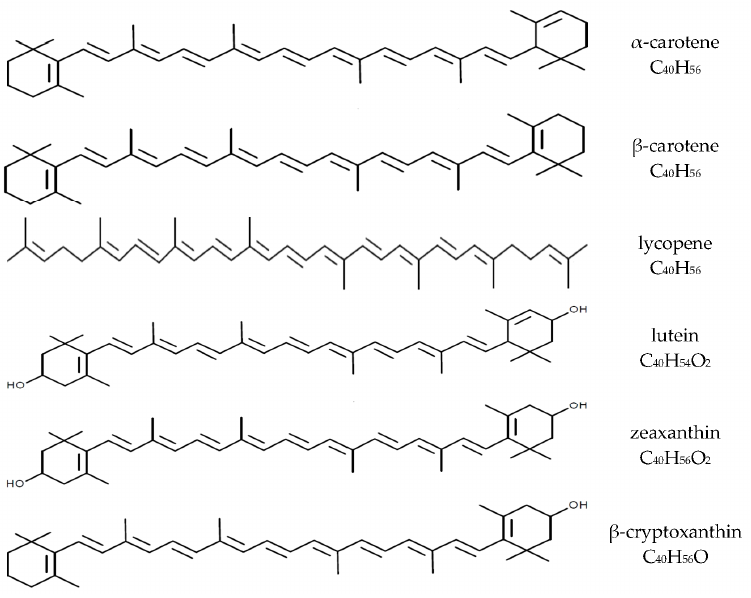
Figure 1. Chemical structures and molecular formulas of selected carotenoids.